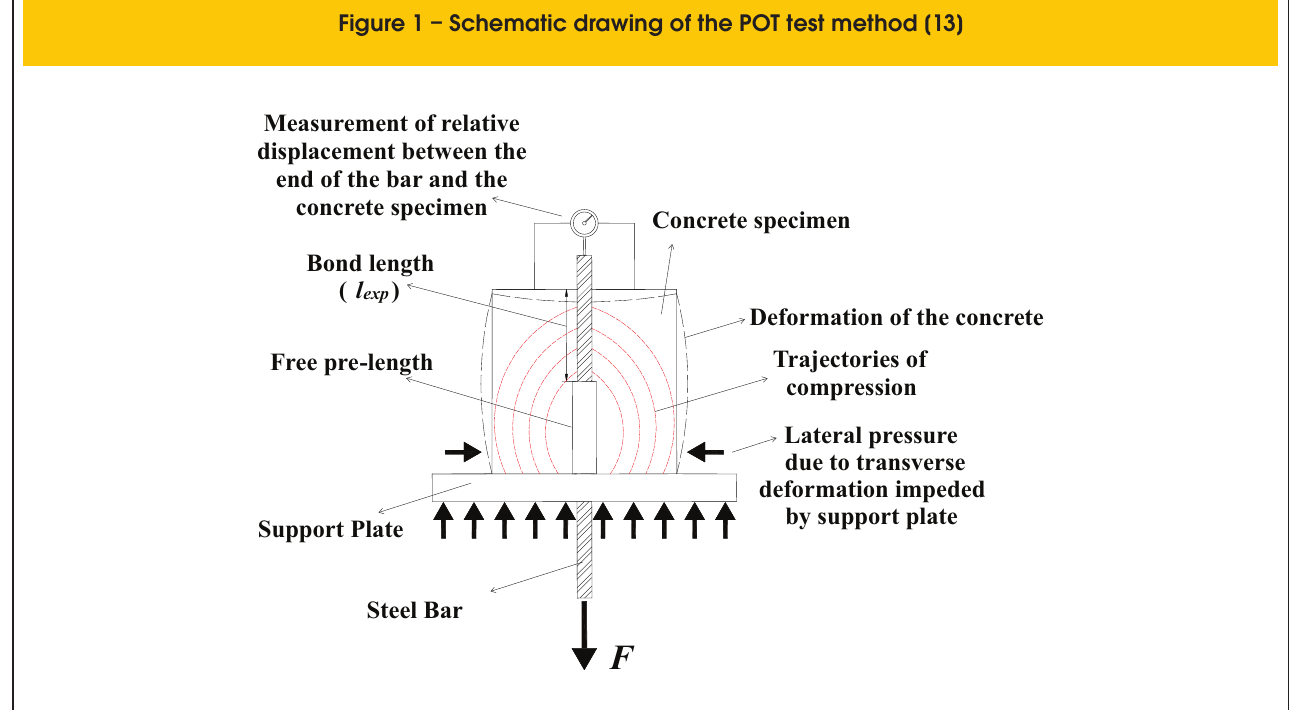
Figure 1 – Schematic drawing of the POT test method